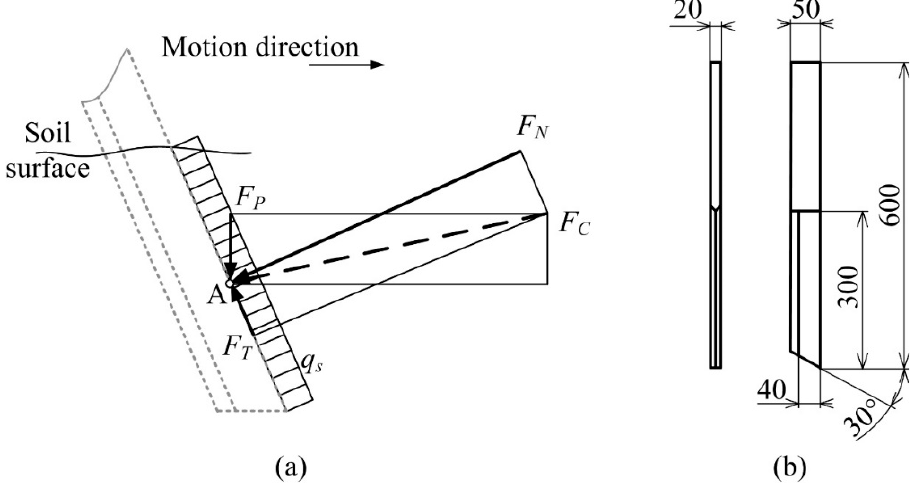
Figure 4. Cutting blade: ( a ) Forces acting on cutting edge: F N —normal force; F F —frictional (tangen ‐ tial) force; F C —soil cutting force; F P —perpendicular force; q s —specific load; α —inclination angle; A—point of action; ( b ) Dimensions.